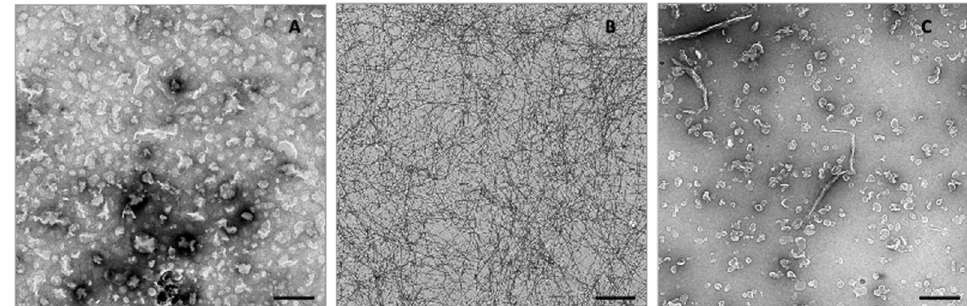
Figure 1. Mutual effect of Hfq-CTR amyloid fibers on lipid bilayers and conversely observed by TEM (negative staining). Transmission electron microscopy images of Hfq-CTR are taken at 2 mg/mL, alone or with EPE liposomes at 1 mg/mL. Panel ( A ): EPE Liposome alone. Note that vesicles are distorted and flattened by negative staining and subsequent TEM analysis. Panel ( B ): Hfq-CTR fibrils alone. Panel ( C ): Hfq-CTR fibrils in the presence of EPE liposomes after 5 min of incubation. Scale bar 1 µm.